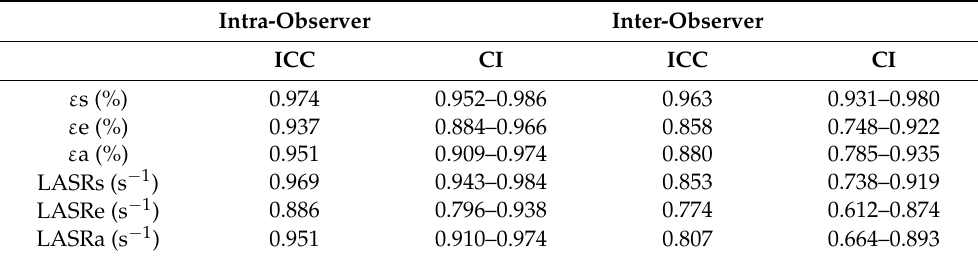
Table 7. Reproducibility of the LA function analysis by